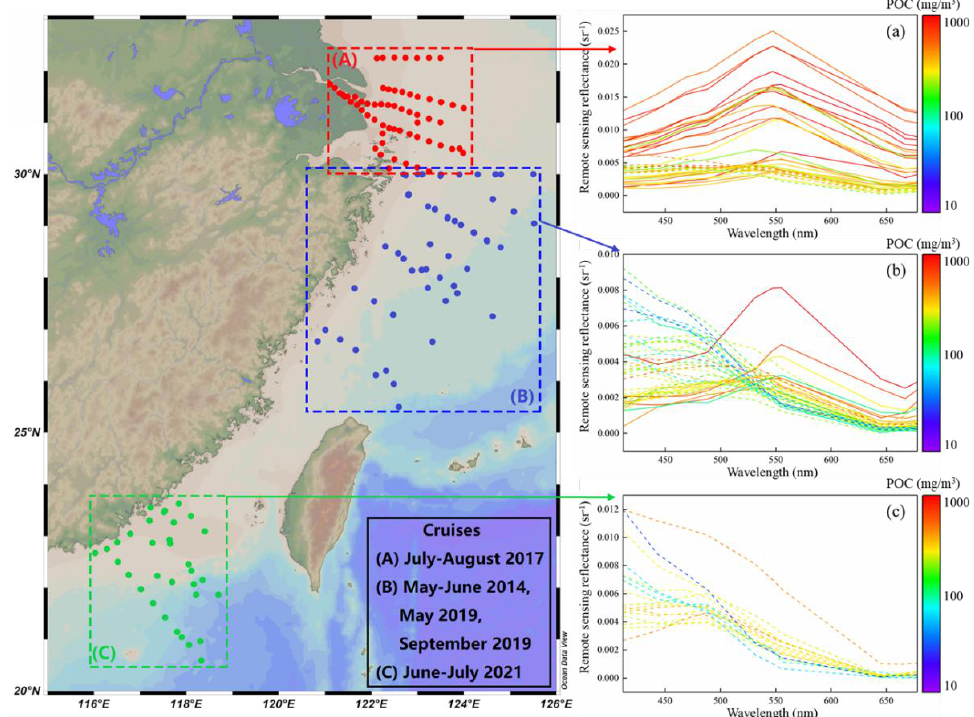
Figure 1. The locations of the measured sample points obtained during the cruises in the Changjiang Estuary, East China Sea, and Chaoshan Sea are shown in boxes ( A – C ), respectively. ( a – c are the remote sensing reflectances extracted from the corresponding locations according to Section 2.2, where the solid line represents type II waters, the dotted line represents type I waters and different colors represent the POC concentration level at the sampling points.)